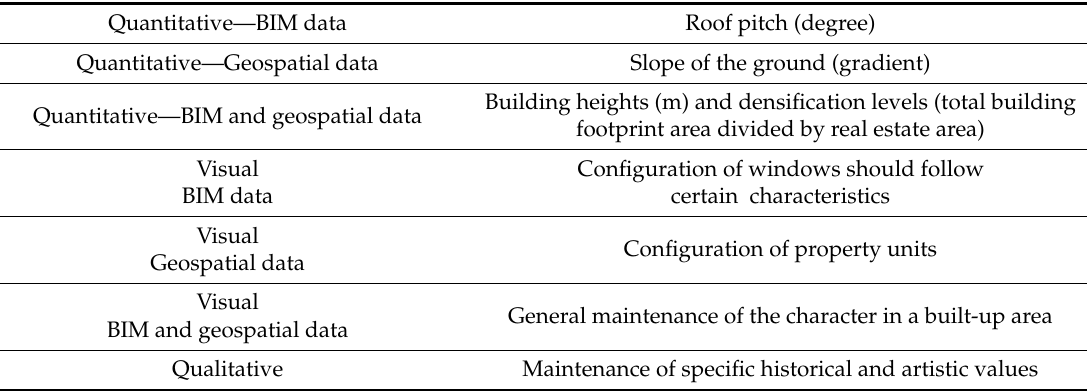
Table 2. Examples of property criteria in the detailed development plan for each